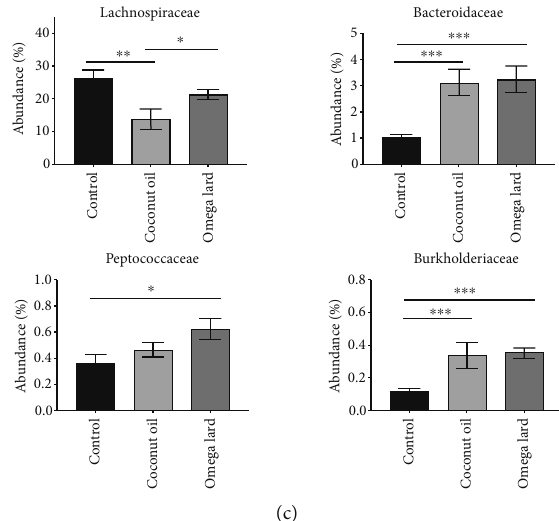
Figure 4: Microbiota analysis. Principal component analysis (PCA) of the fecal microbiome (a) is shown. Control, coconut oil, and omega lard represent the control, coconut oil-fed, and omega lard-fed groups, respectively. All feces samples were collected at the end of the experiment (four weeks). The number of animals was 8, 7, and 8 in the control, coconut oil-fed, and omega lard-fed groups, respectively. The PCA of the fecal microbiome was performed using Bray – Curtis measurements. The control, coconut oil-fed, and omega lard-fed groups are represented by red, blue, and yellow circles, respectively. The relative abundance of bacterial families in the fecal microbiome (b) is shown, where each bacterial family is indicated by a di ff erent color. The comparison of the relative abundance of bacterial families in the fecal microbiome between the groups is shown for Lachnospiraceae , Bacteroidaceae , Peptococcaceae , and Burkholderiaceae (c). The abundance (%) of the bacterial population is indicated on the y -axis and the groups on the x -axis. Data are presented as mean ± SEM . Asterisks indicate signi fi cant di ff erences between groups ( P < 0 : 05 ).